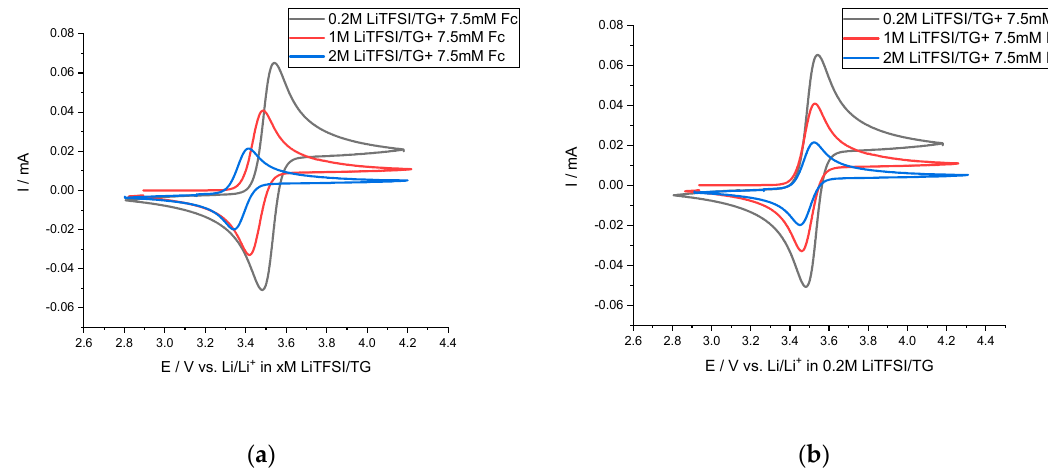
Figure 3. a) Cyclic voltammograms (CVs) recorded for three different concentrations, b) CVs Figure 3. ( a ) Cyclic voltammograms (CVs) recorded for three di ff erent concentrations, ( b ) CVs rescaled rescaled according to the reference potential of 0.2 M LiTFSI/TG : WE: Au disk, CE/RE: Li strip according to the reference potential of 0.2 M LiTFSI / TG: WE: Au disk, CE / RE: Li strip immersed in the immersed in the respective electrolyte under study, sweep rate: 10 mV/s. Here, x = 0.2, 1 , 2 M. respective electrolyte under study, sweep rate: 10 mV / s. Here, x = 0.2, 1, 2